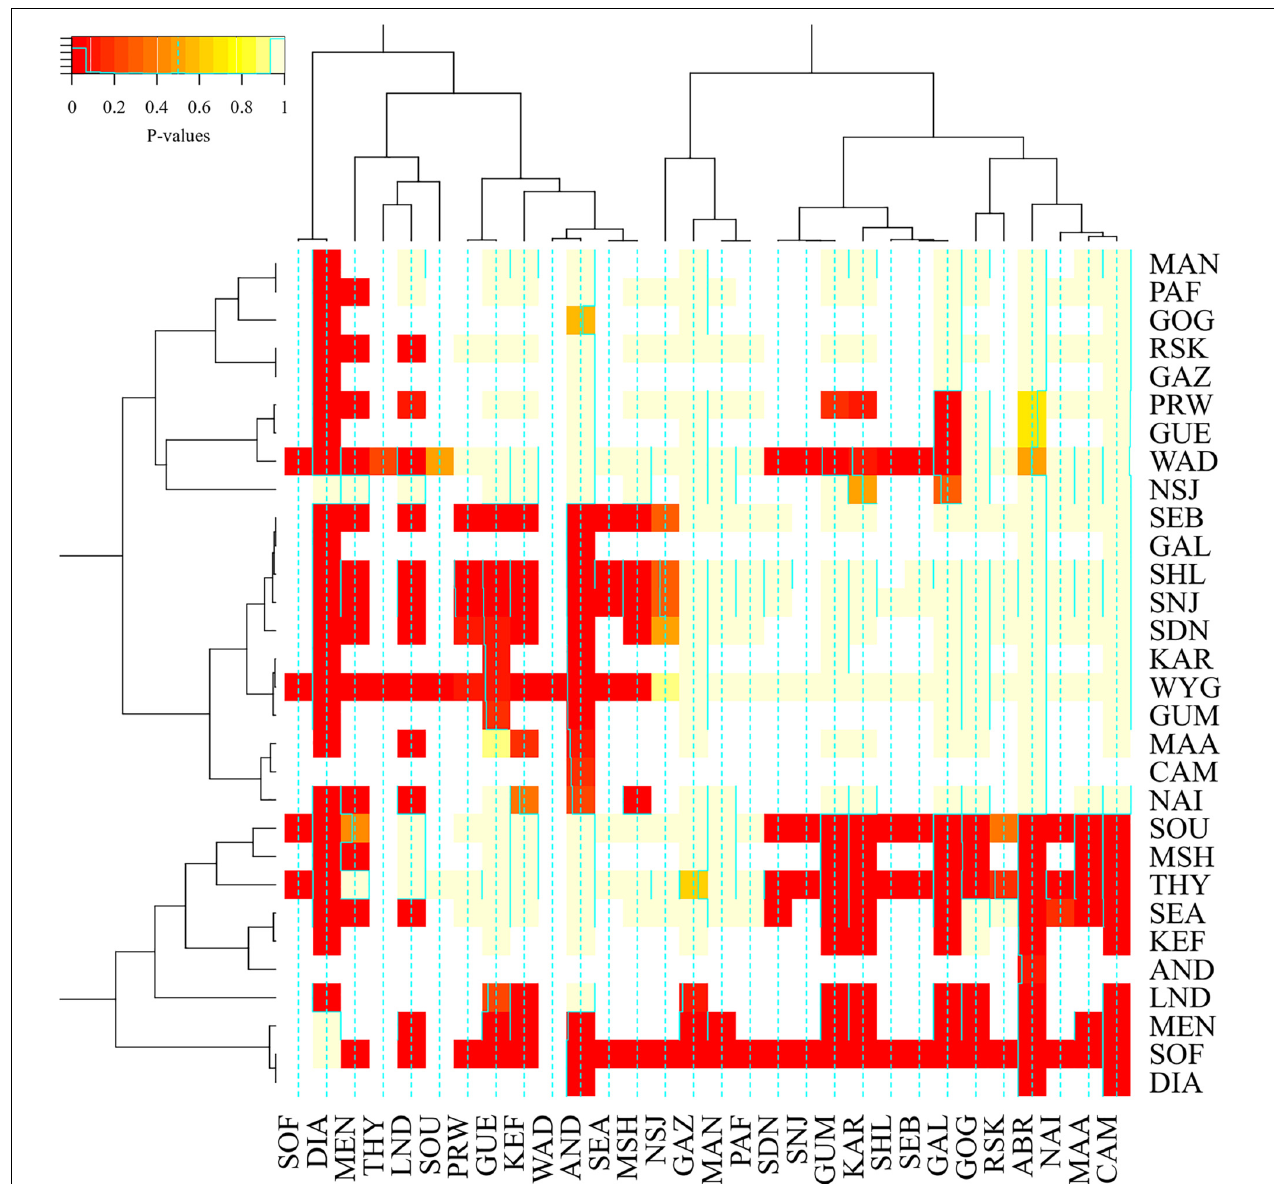
FIGURE 8 | A heat-map plot of the p -values for the pair-wise comparison of inbreeding values between breeds. The darker the red color, the more different the breeds are in terms of